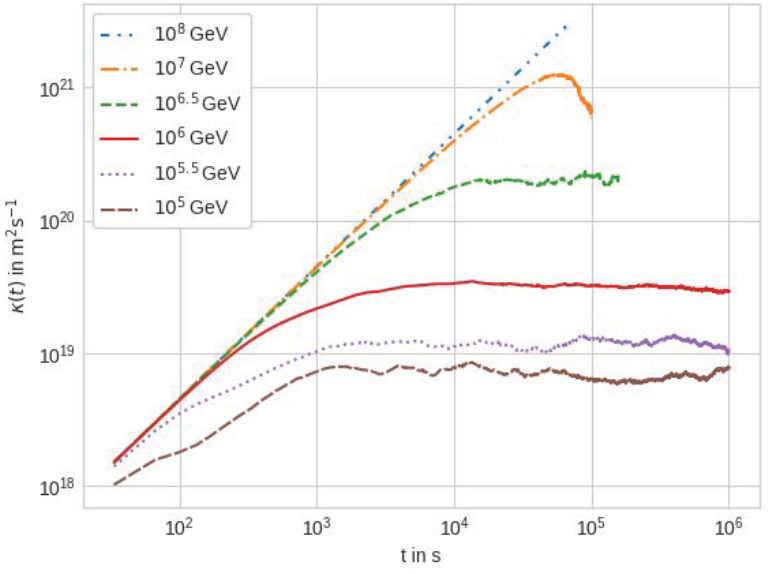
Figure 5. Running diffusion coefficient, κ , for energies 10 5 GeV to 10 8 GeV. A plateau is built up for energies between 10 5 GeV < E < 10 6 GeV. Toward higher energies, the coefficient breaks off as the particles leave the plasmoid before they can reach the steady-state diffusion coefficient. This is consistent with the calculated energy for a transition between a ballistic and diffusive behavior at 10 6